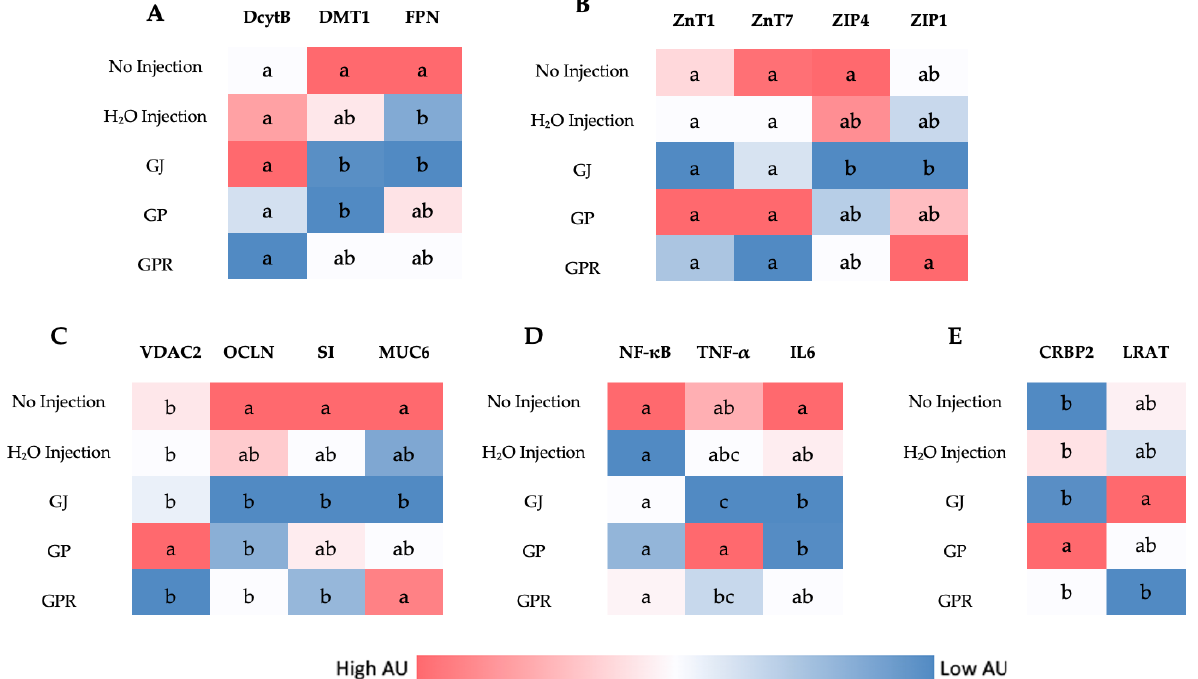
Figure 3. Heatmap showing the effect of intra-amniotic administration of grape juice (GJ), pomace (GP), and puree (GPR) on liver gene expression. Values are in arbitrary units (AU). Genes not in- dicated by the same letter (a,b,c) are significantly different ( p < 0.05). Key; STRA6: Signaling re- ceptor and transporter of retinol; RBP: Retinol-binding protein.